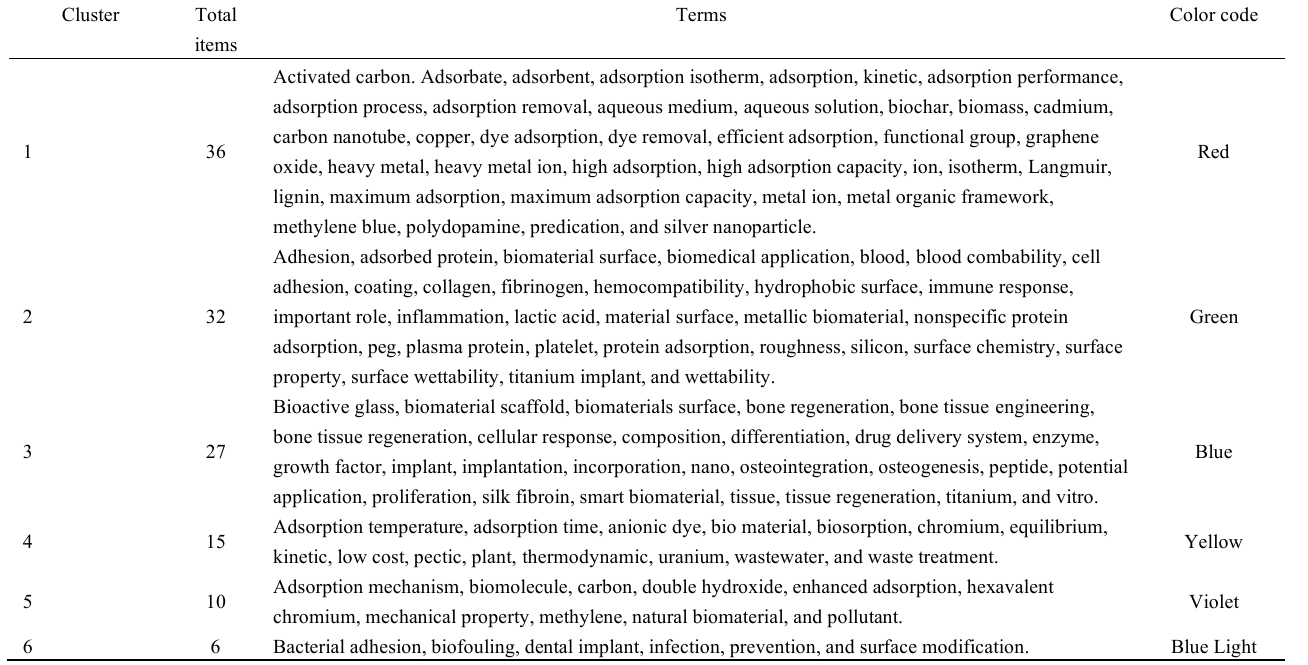
Table 5. VOSviewer Distribution of term mapping